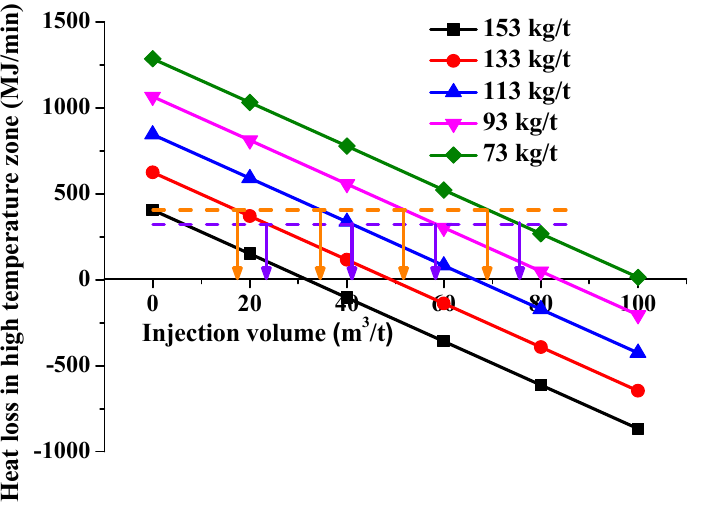
Figure 5. Effect of NG injection on heat loss in the high temperature zone of blast furnace under different coal ratios.